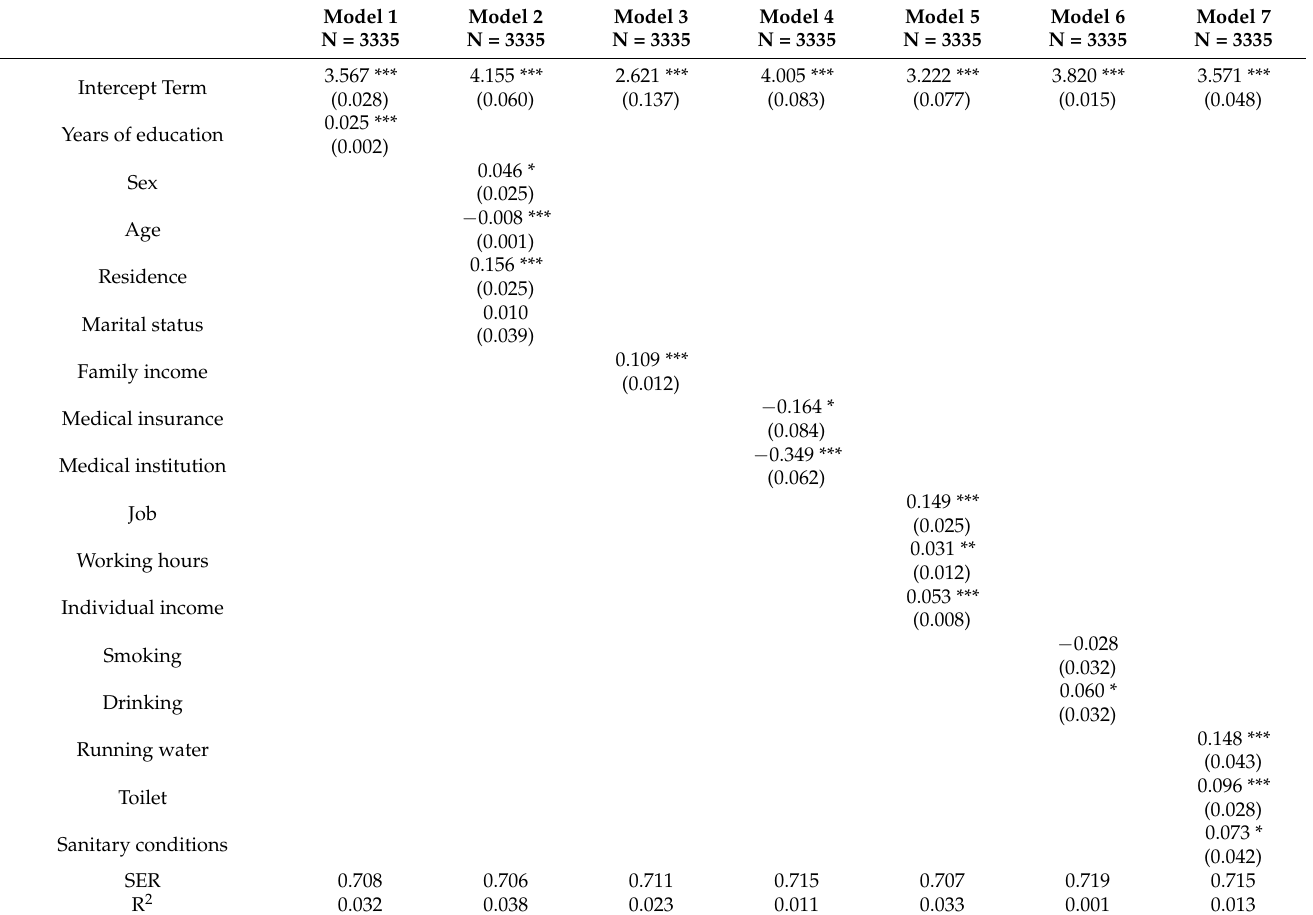
Table A5. Results for physical health.